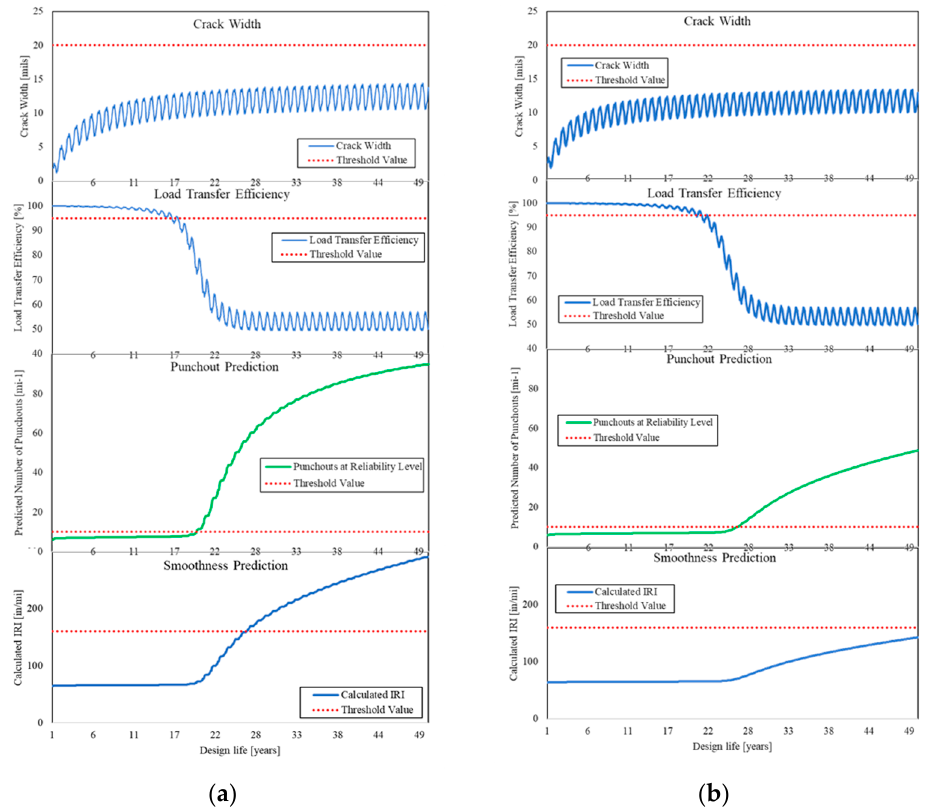
Figure 12. Variation of: CW, LTE, punchout prediction and smoothness prediction over time from MEPDG, ( a ): A4, and ( b ): E313.